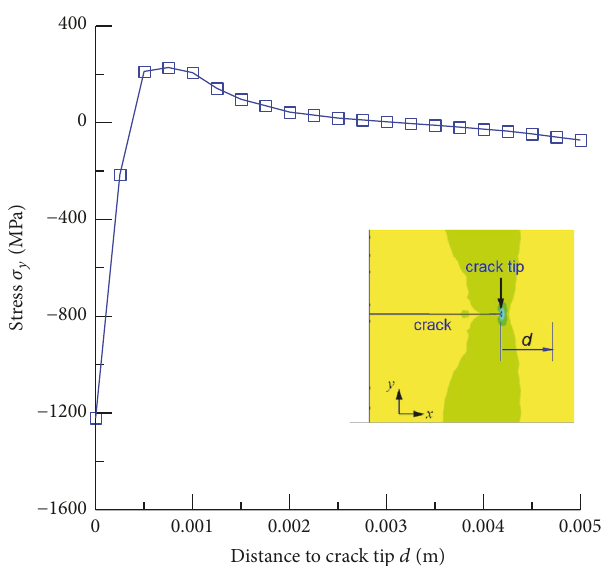
Figure 12: Stress distribution in front to crack tip ( 𝑡 = 600 s).